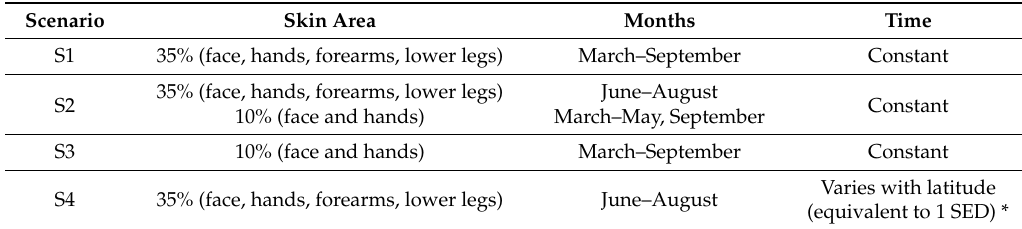
Table 2. The four noontime UVR sunlight exposure